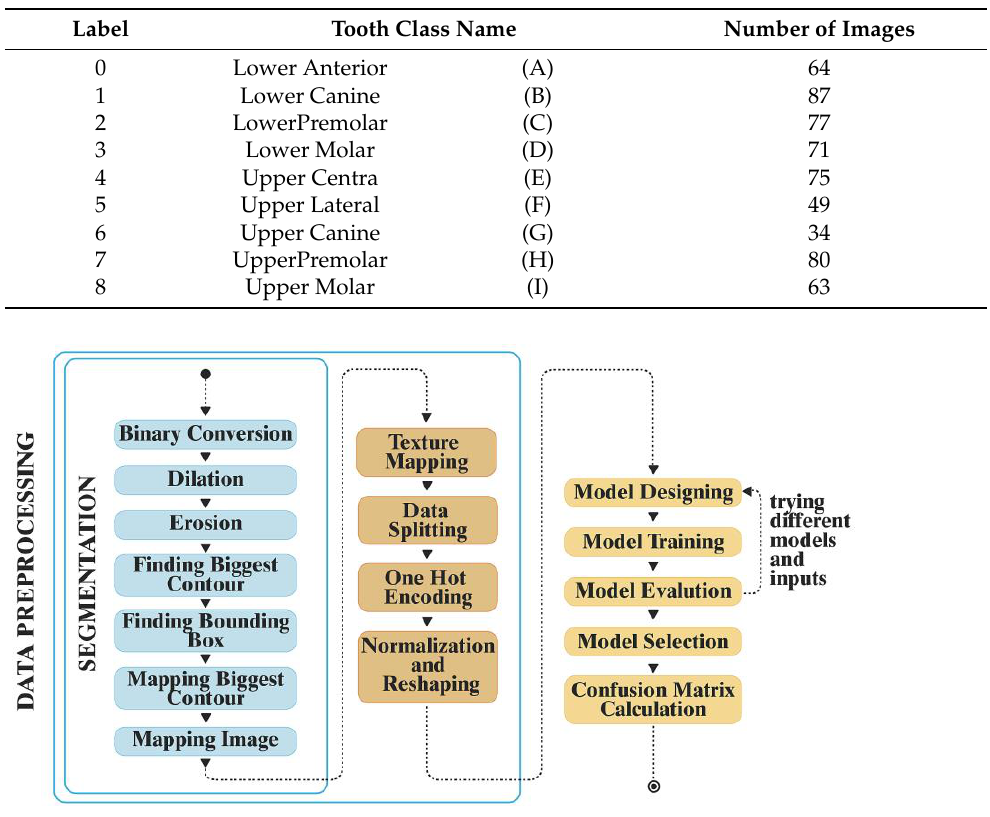
Figure 1. Process of the convolutional neural network (CNN)-based AI model used in the study. First is data preprocessing, which includes segmentation, followed by texture mapping, and finally model designing and